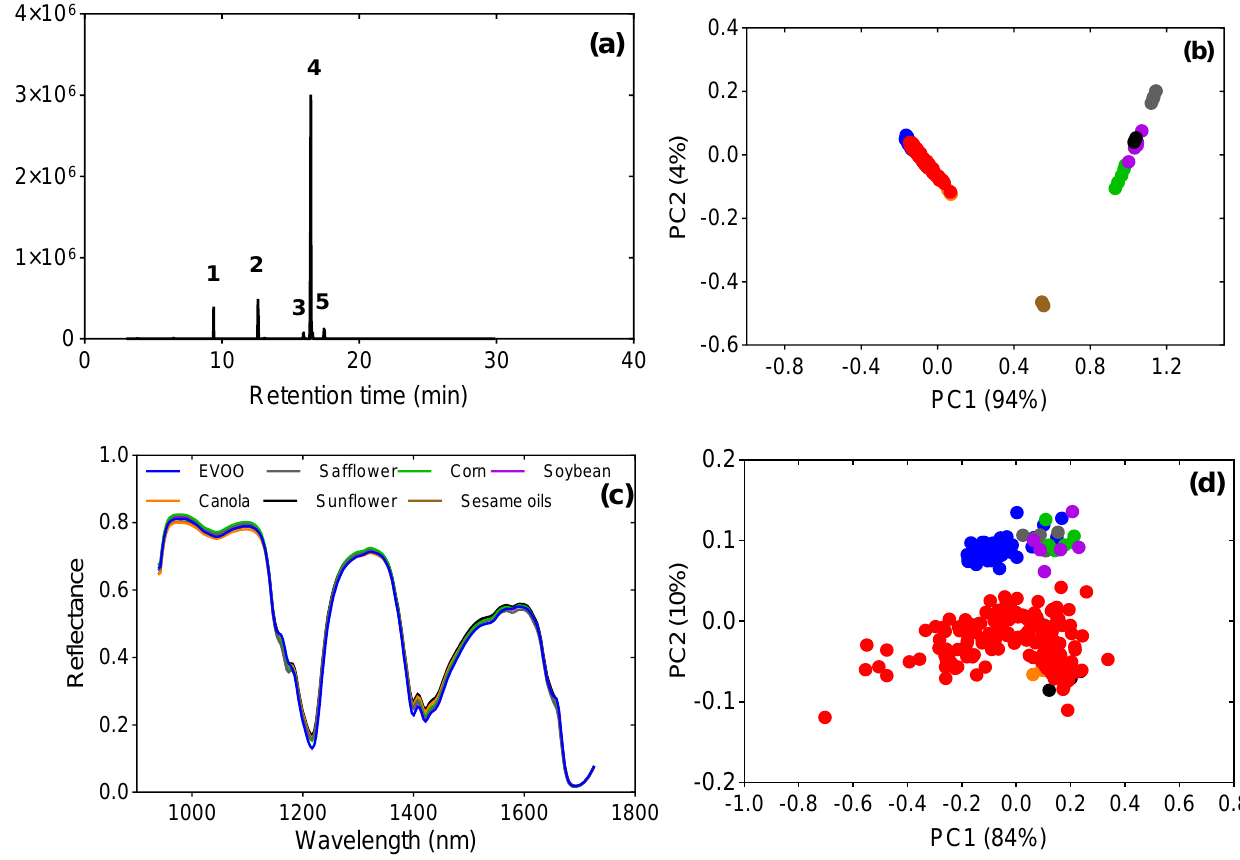
Figure 3. ( a ) Typical FAME GC-MS chromatogram for extra-virgin olive oil (EVOO). Peaks: 1— internal standard (tridecanoic acid); 2—C16:0; 3—C18:0; 4—C18:1, cis -9; 5—C18:2; ( b ) PC plot from GC-MS fatty acids composition data showing the relationship between EVOO, other edible oils and adulterated olive oil; ( c ) HSI spectra profile of EVOO and other edible oils; ( d ) HSI PC scores plot showing the relationship between EVOO, other vegetable oils and adulterated olive oil. Groups